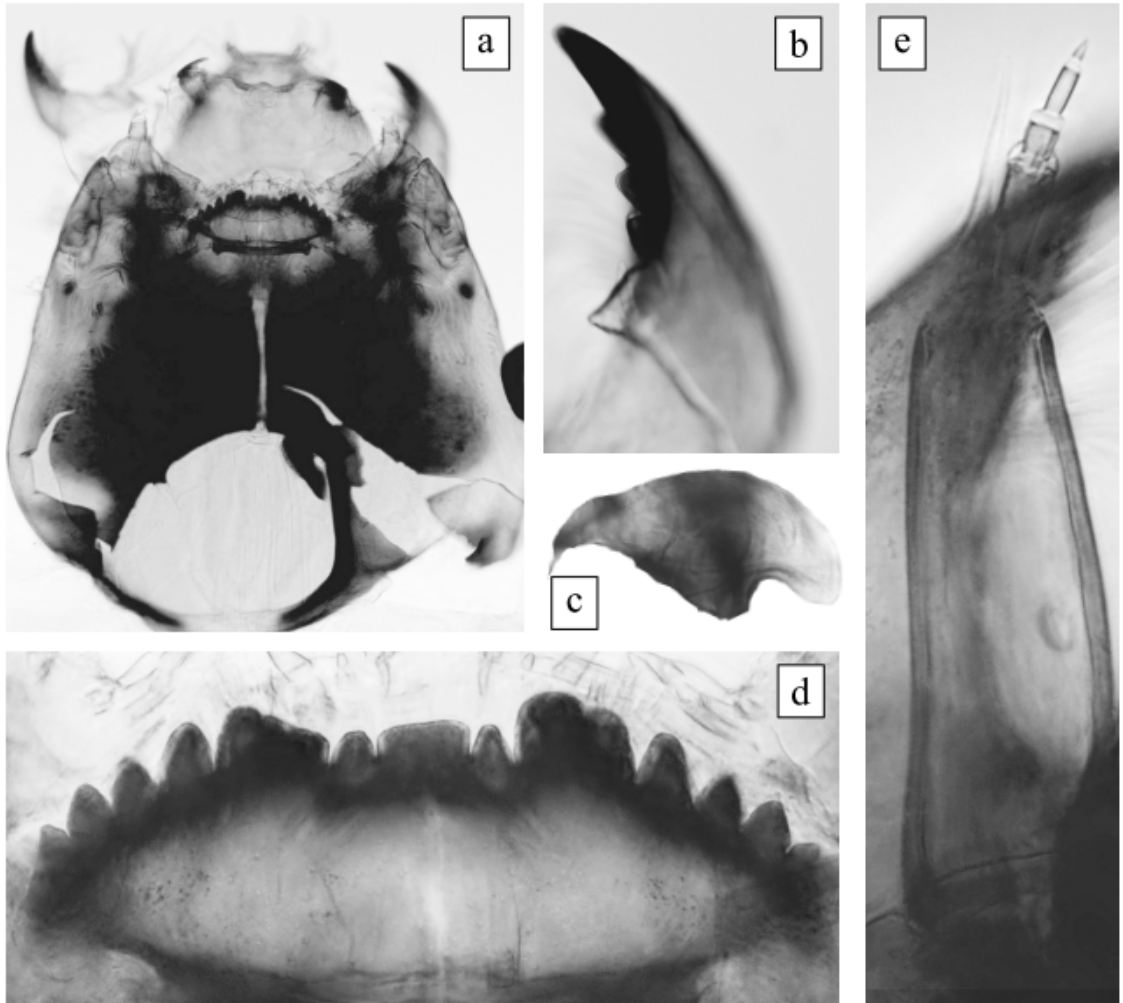
Figure 1. Larva morphology of Ch. agilis 2 from Kurchatskoe Lake. ( a ) Head capsule, ( b ) mandible (fragment), ( c ) ventromental plate, ( d ) mentum, and ( e ) antenna.